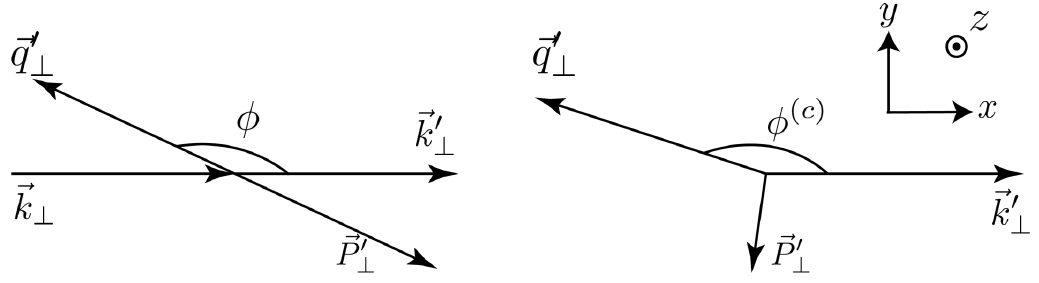
= − ~P 0 and ~k 0 = − ~k , while the transverse momenta in ⊥ ⊥ ⊥ ⊥